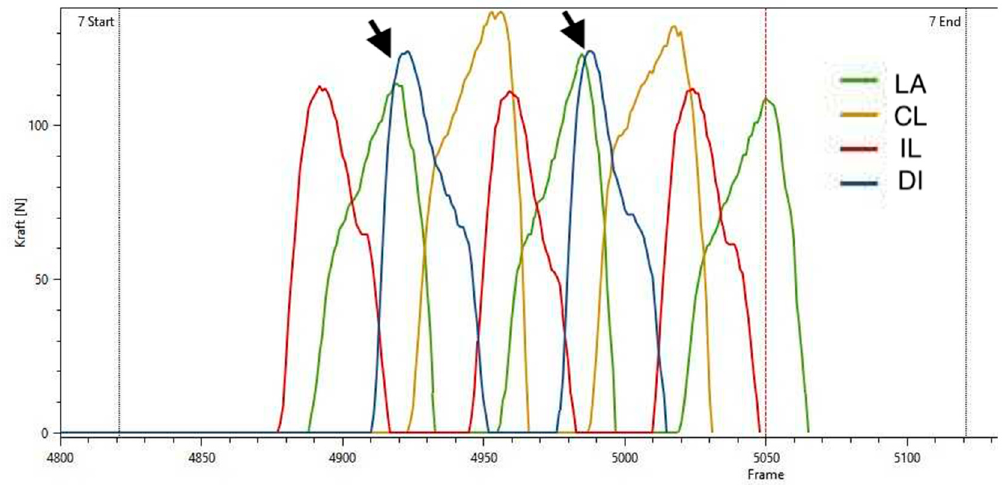
Figure 20. Illustration of the ground reaction forces of a dog from study group 2 as a function of force and time. Each curve corresponds to a contact between a paw and the ground. The arrows mark moments when a reduced load on the lame front limb is superseded by an increased load on the diagonal hind limb. LA = lame limb, CL = contralateral limb, IL = ipsilateral limb, DI = diagonal limb.